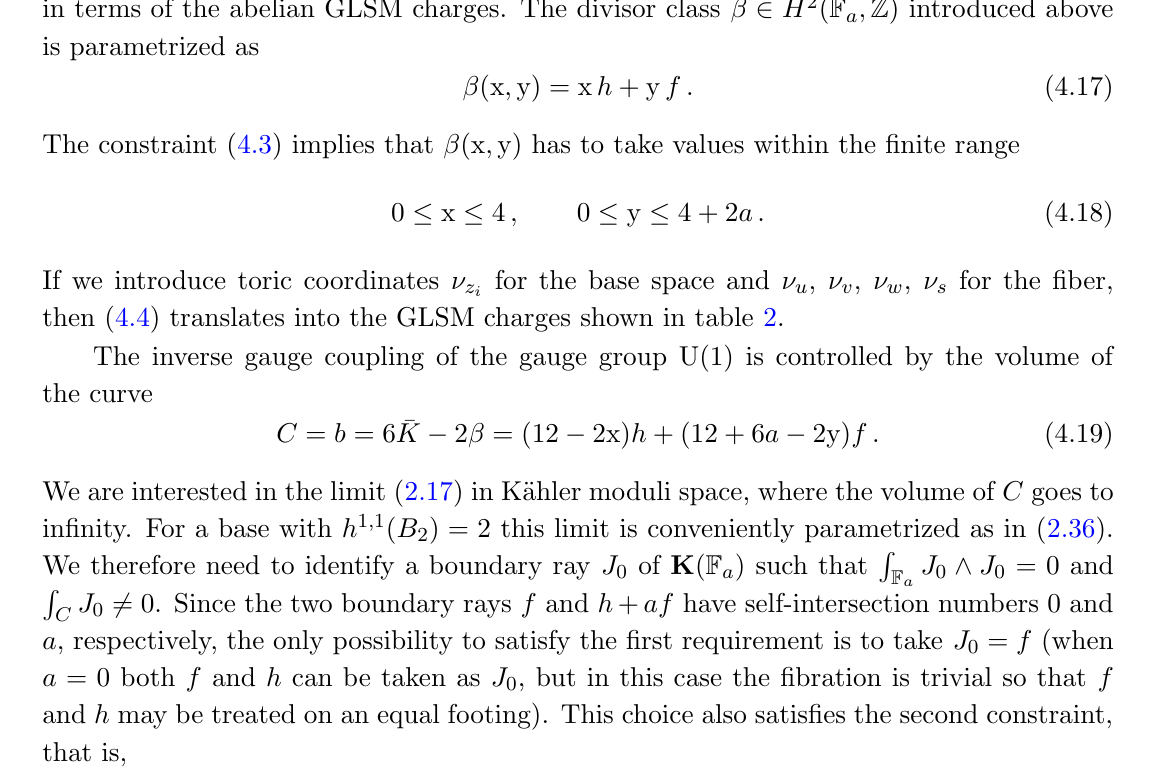
where Span h(cid:1)i denotes the set of non-negative linear combinations of the indicated divi- sor